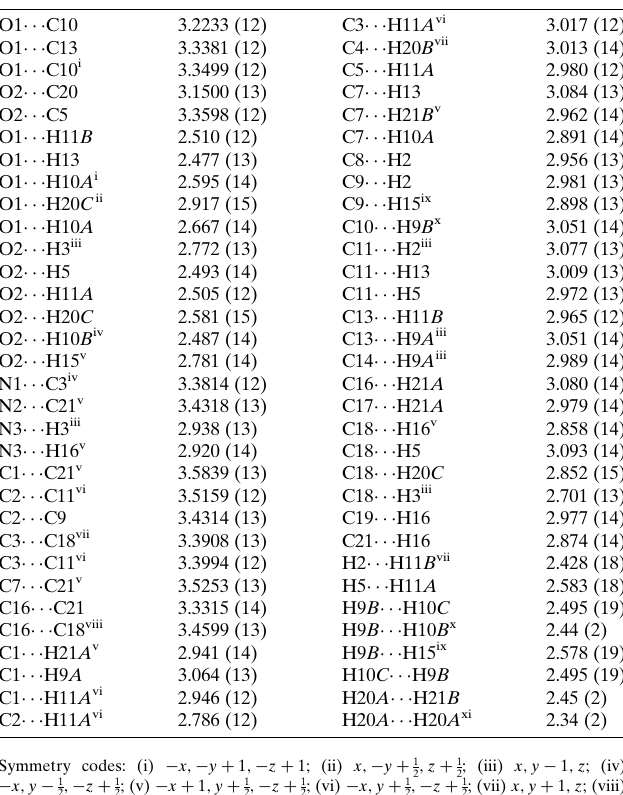
Table 2 Selected interatomic distances (A˚ ).